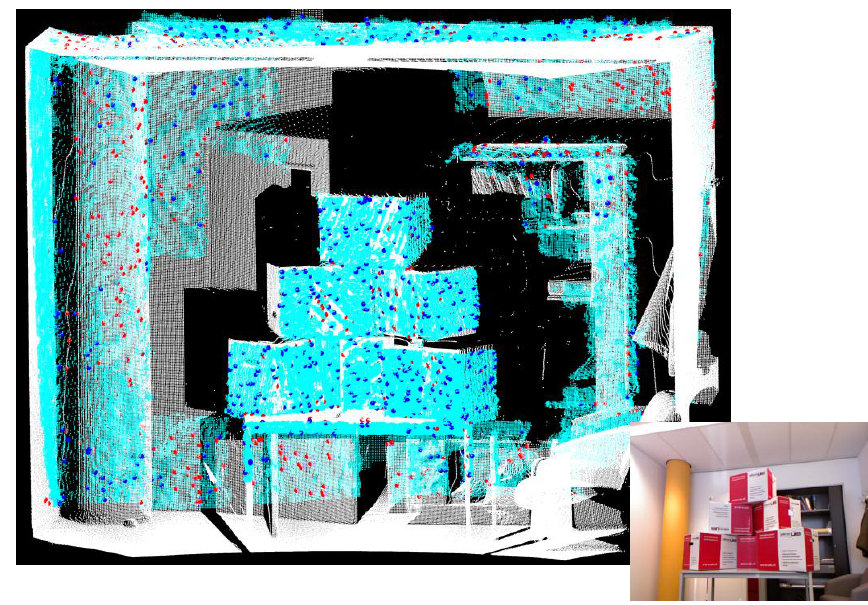
Figure 6. Comparison of Kinect point cloud ( cyan ) with the point cloud obtained by FARO LS880 laser scanner ( white ). The larger points are samples randomly selected from the Kinect data ( blue ) and their closest point in the laser scanner data ( red ). The thumbnail on the lower right is a color image of the setup.